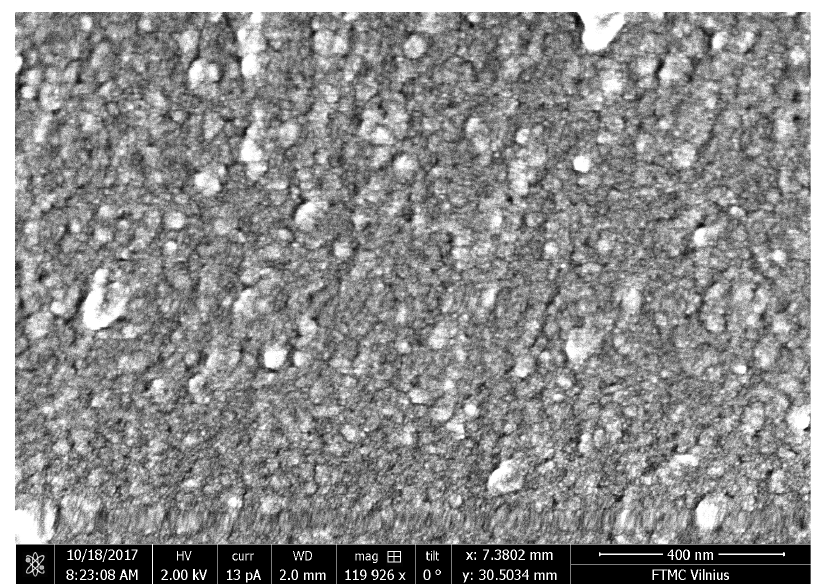
Figure 1. Scanning electron microscopy of composite material with 3 vol % of Ni@C.